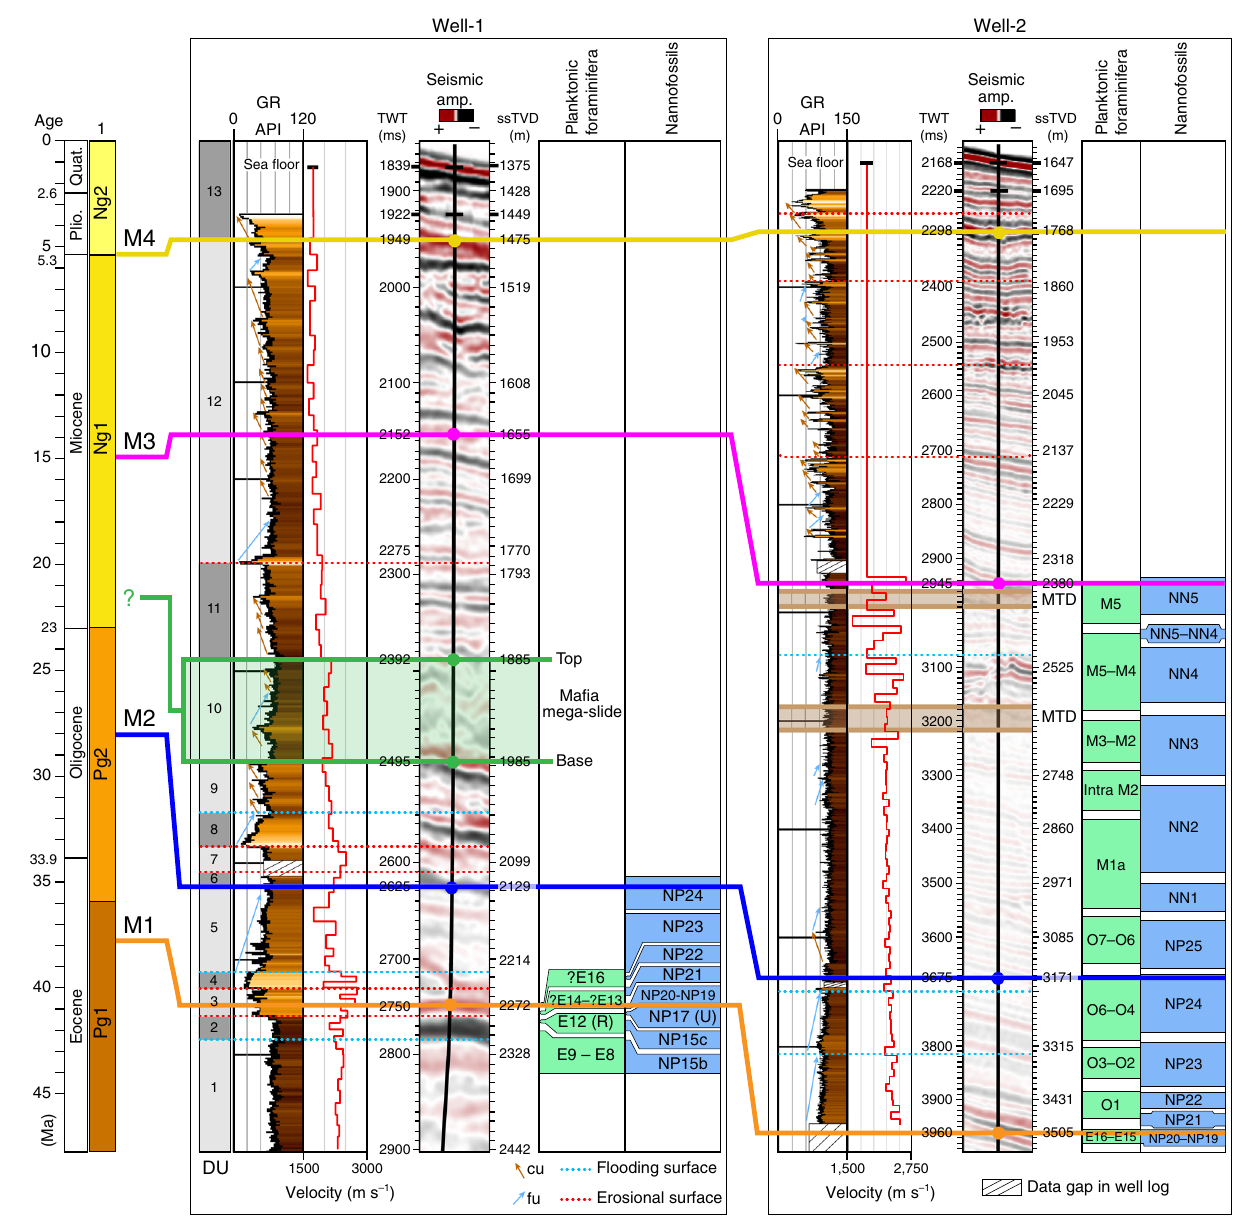
Fig. 2 Well-to-seismic tie and biostratigraphy of Well-1 and Well-2. Well-to-seismic tie of Well-1 and Well-2 with dated stratigraphic horizons (M1 – M4), seismic amplitude at the well sites, Gamma-Ray (GR), velocity model from check-shots, depth below sea level in two-way travel time (TWT, milliseconds) and true vertical depth (ssTVD, meters), planktonic foraminifera and nannofossil zones. The Ma fi a mega-slide is highlighted in green. 1: Stratigraphic sequences from ref. 42 ; DU: depositional units (Supplementary Note 2); fu: fi ning-upward, cu: coarsening-upward, MTD: mass-transport